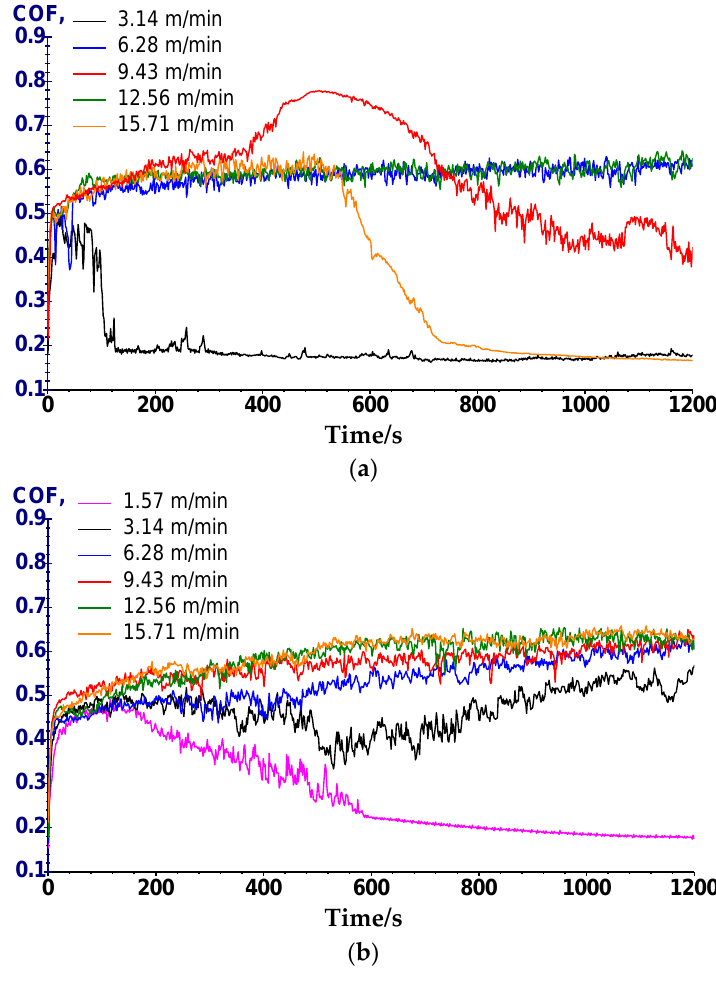
Figure 8. Friction coefficient curves of the two groups of samples with different porosities under different sliding speeds: ( a ) friction coefficient curves with the porosity ε = ~24%–26%; and ( b ) friction coefficient curves with the porosity ε = ~38%–42%.